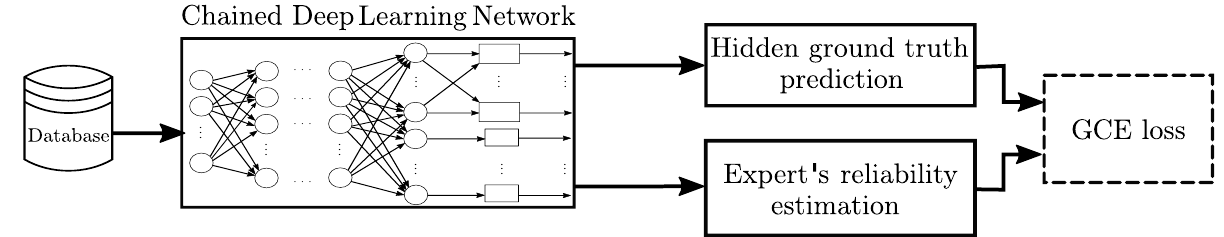
Figure 1. GCECDL sketch for multiple-annotator classification holding ground truth prediction and instance-based expert reliability